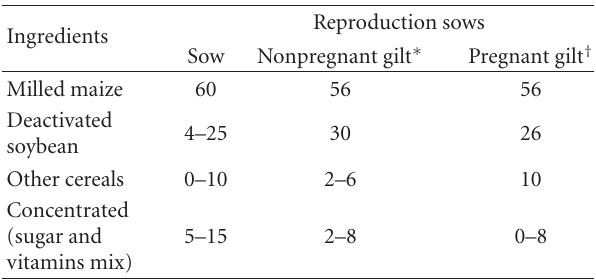
Table 1: Composition (%) of feed intended for sows at di ff erent reproductive